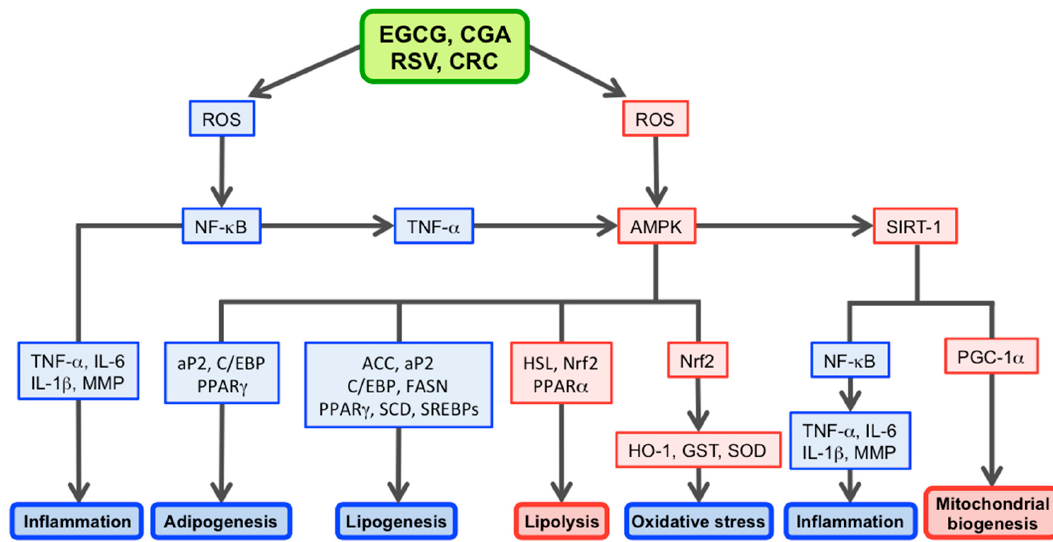
Figure 2. Potential anti-obesity mechanisms whereby EGCG, CGA, RSV, and CRC exert anti-obesity effects by scavenging/downregulating ROS. Red boxes represent upregulation/stimulation, whereas blue boxes represent downregulation/suppression.